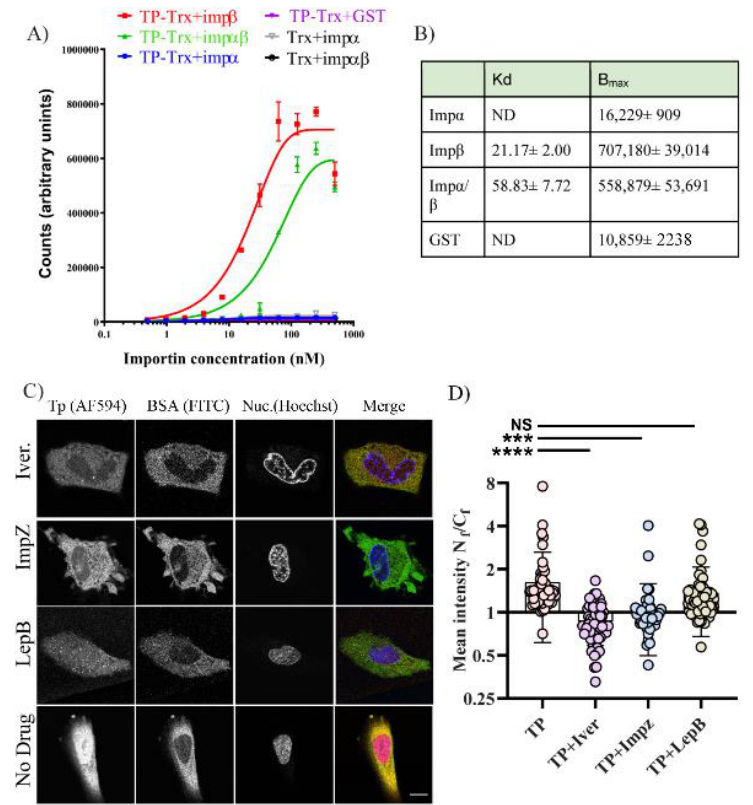
Figure 7. TP–Trx binds to both Imp β 1 and the Imp α / β 1 heterodimer and inhibitors of importins lower TP–Trx nuclear accumulation. ( A ) Triplicate wells containing 30 nM TP were incubated with increasing concentrations of Imp α , Imp β 1, Imp α / β 1 heterodimer, or a GST polypeptide control. Single representative curves are shown. As a control, the tags alone without TP were also tested and did not bind with Imp α / β 1 heterodimer or Imp α using 60 nM concentrations of Trx tag. The tag has no binding affinity to both Imps. ( B ) Pooled data from AlphaScreens for binding affinities (K d ) and maximal binding (B max ). Data are displayed as mean ± SEM (n = 4). ND, signals were too low to determine K d s. ( C ) Representative images from microinjection experiment described and quantified in ( D ). TP–Trx was microinjected using a combination of TP–Trx and BSA–FITC in Hela cells. Before microinjection, the cells were incubated for 3 h with either DMSO, or with ivermectin (30 µ M), importazole (40 µ M), and leptomycin (10 ng/ul). The microscopy images show a change of TP–Trx distribution using either ivermectin or importazole. Acquiring images started 20–30 min after microinjection. Scale bar = 15 µ M. ( D ) Results from calculating TP N f /C f after microinjecting TP–Trx with BSA cytoplasmic marker. Cells were incubated with Leptomycin B (LepB), Importazole (ImpZ) or Ivermectin (Iver) or were examined in the absence of the drug. Graphs presented as mean ± SD. Data were derived from at least two independent biological replicates (n cells ≥ 45). NS, not